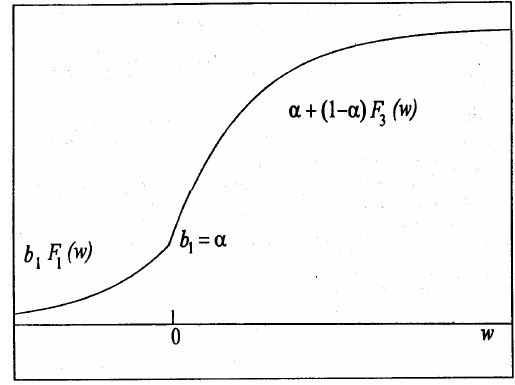
Figure 3 – Cumulative distribution function of a net wealth distribution, b 2